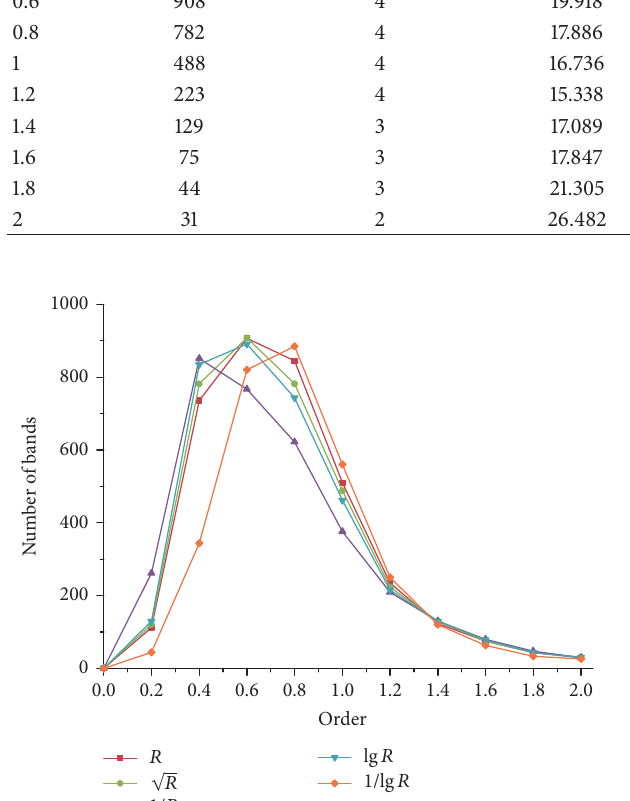
Figure 5: The numbers of bands passed the significance test and trend